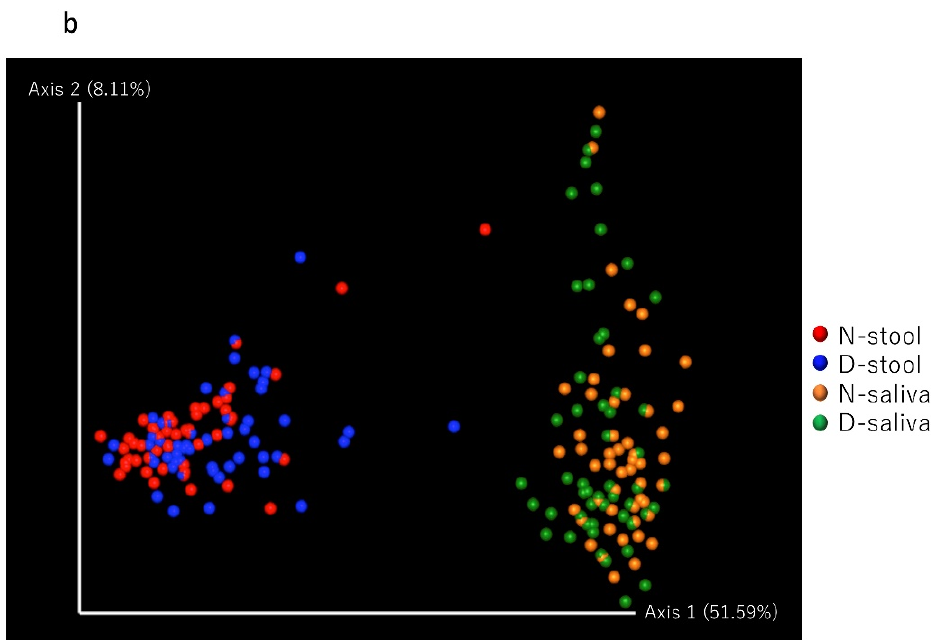
Figure 2. Diversity analysis. ( a ) Although β diversity was not significantly different in saliva samples between controls and patients with CRC, it was significantly different in stool samples between the groups. The significance test was evaluated using permutational multivariant analysis of variance (PERMANOVA). ( b ) Principal coordinate analysis (PCoA) plots based on weighted UniFrac distance analysis of the microbiota in each sample. Closer plots indicate a more similar microbiota composition. Axis 1 and Axis 2 indicate the percentage of variation explained by principal coordi-